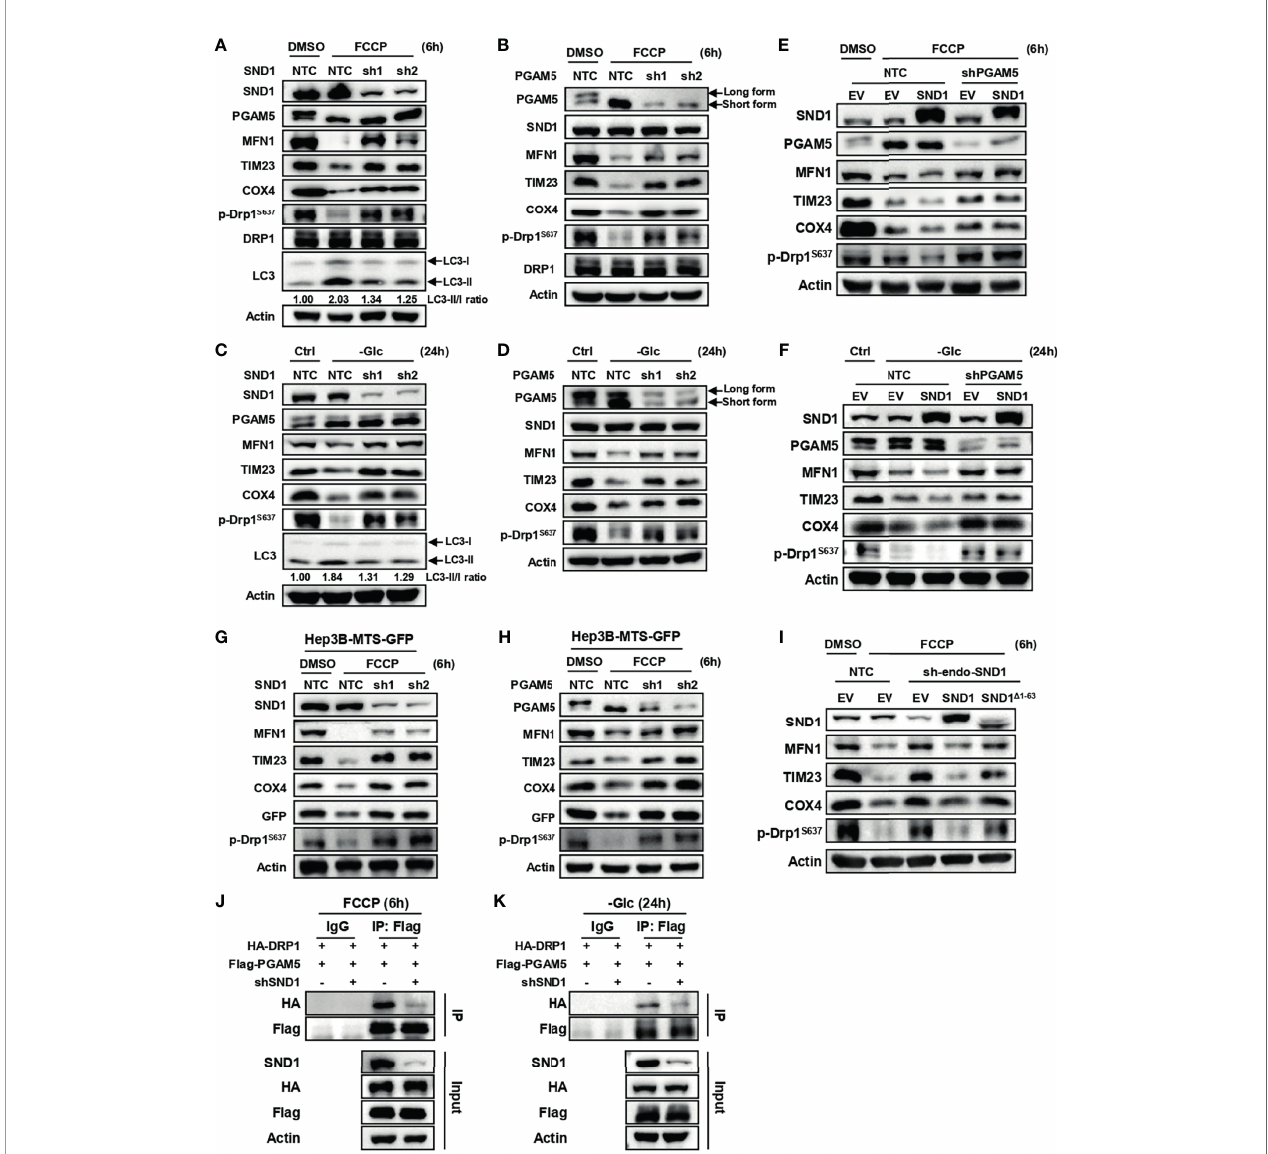
FIGURE 5 | SND1 promotes mitophagy through PGAM5. (A, B) Hep3B cells stably expressing shSND1 (A) or shPGAM5 (B) were treated with 10 m M FCCP for 6 h. Samples were collected for immunoblotting to analyze the expression of SND1, PGAM5, MFN1, TIM23, COX4, p-DRP1 S637 , and DRP1. Actin served as